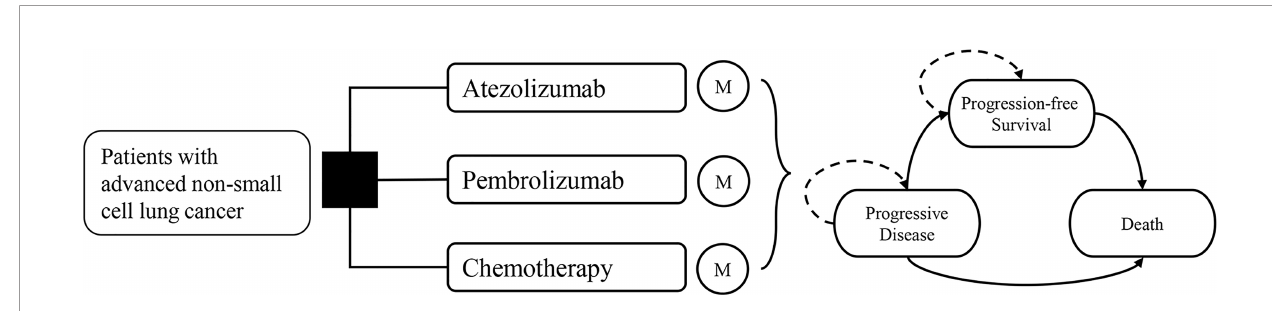
FIGURE 1 | Model structure and